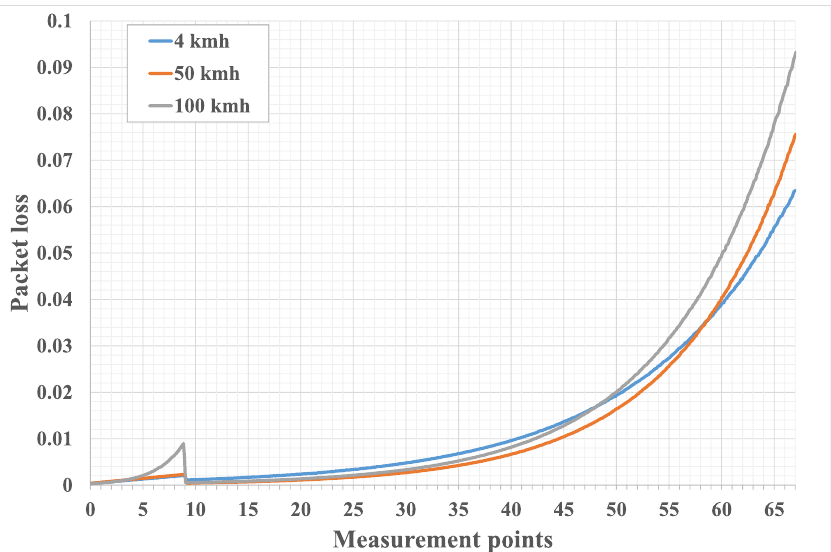
Figure 8. Packet loss for different UE velocities. This figure shows packet loss plotted against measurement points from Figure 7. The blue line corresponds to the pedestrian UE walking along the trajectory, the red line corresponds to the UE riding a scooter, the gray line corresponds to the UE riding a car with velocity comparable to that of the